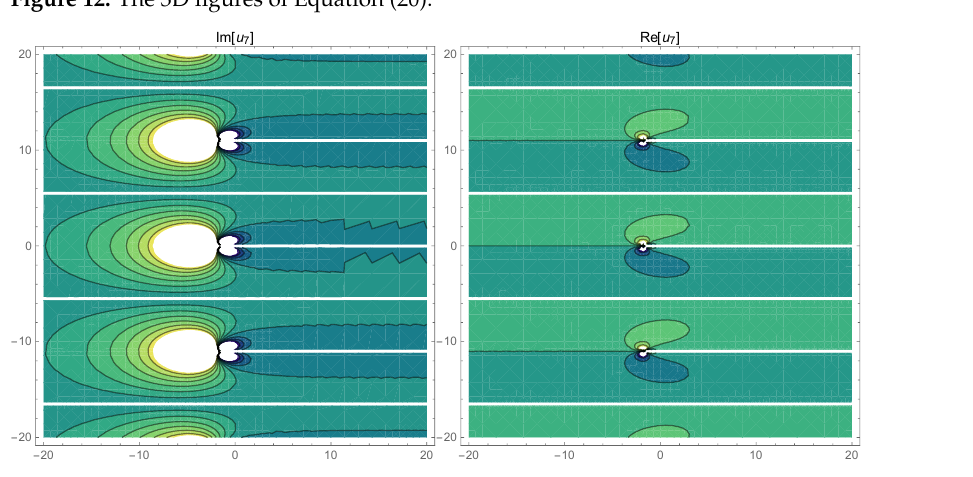
Figure 12. The 3D figures of Equation (20).